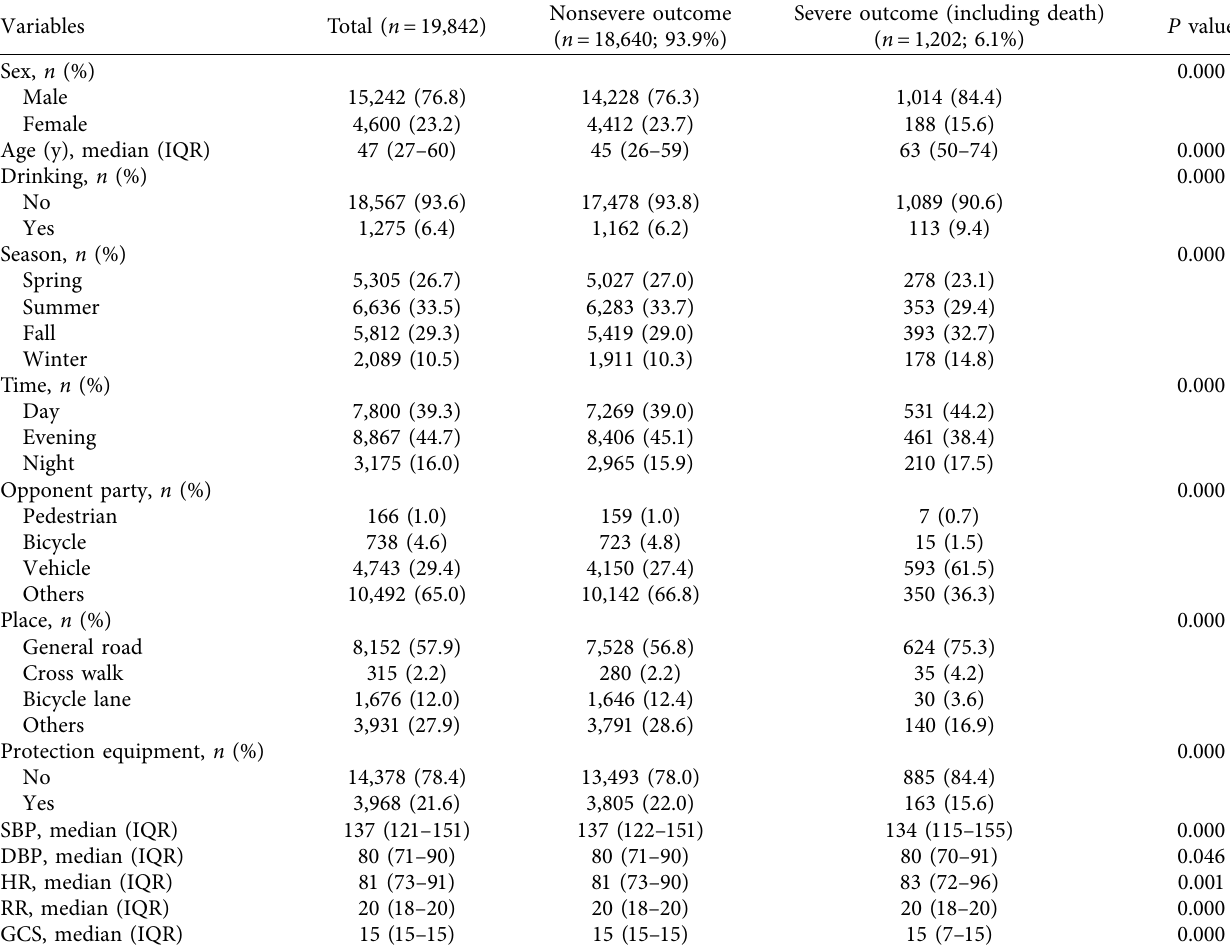
Table 1: General characteristics according to the clinical outcome at